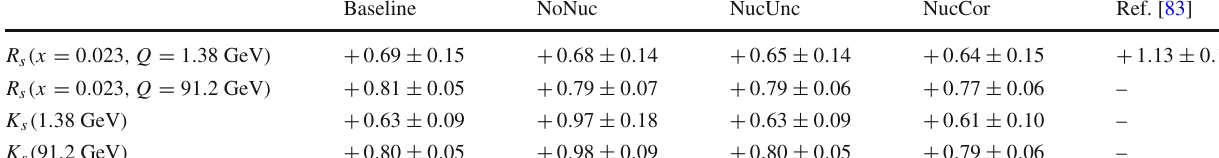
Table 4 The fractions R s , Eq. (13), and K s , Eq. (14), for representative values of x and Q